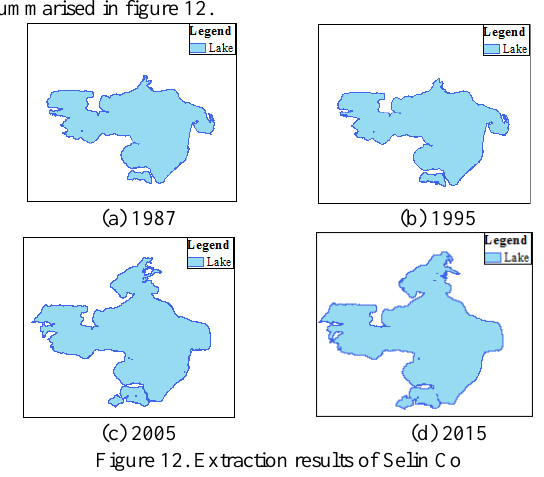
Figure 12. Extraction results of Selin